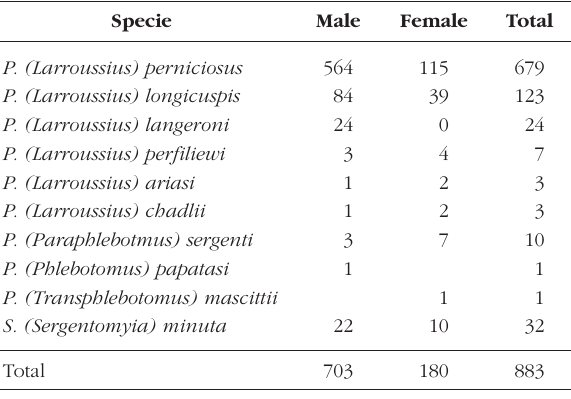
Table I. – Sand fly species diversity in LNI, Kabylian area during summer